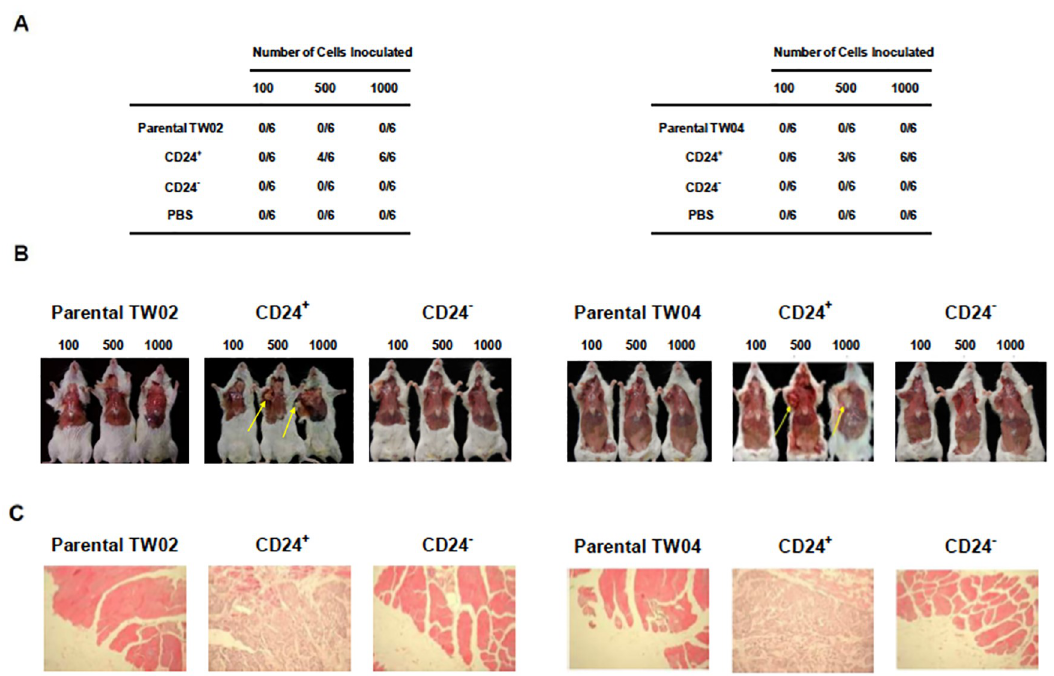
Fig 7. A low number of CD24+ NPC cells initiates tumor formation in NOD/SCID mice. (A) Formation of tumors following injection of CD24+ cells. Groups of six NOD/SCID mice were injected with 100, 500, or 1,000 freshly-sorted CD24+ or CD24 − cells from the TW02 (left) or TW04 (right) cell line. Mice injected with PBS were used as a negative control. Tumor formation was assessed 12 weeks after cell inoculation. (B) Mice injected with TW02 (left) or TW04 (right) cells were sacrificed for evaluation of tumor formation twelve weeks after inoculation. The arrows indicate the presence of tumors in mice injected with 500 or 1,000 CD24+ cells. (C) Tissue H&E staining results of TW02 (left) and TW04 (right) mice inoculated with 500 cells. Inoculation of as few as 500 CD24+ cells produced histological signs of tumors at the site of